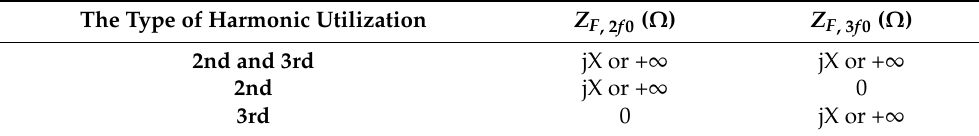
Table 2. The input impedances of the DC-pass filter in different harmonic utilization